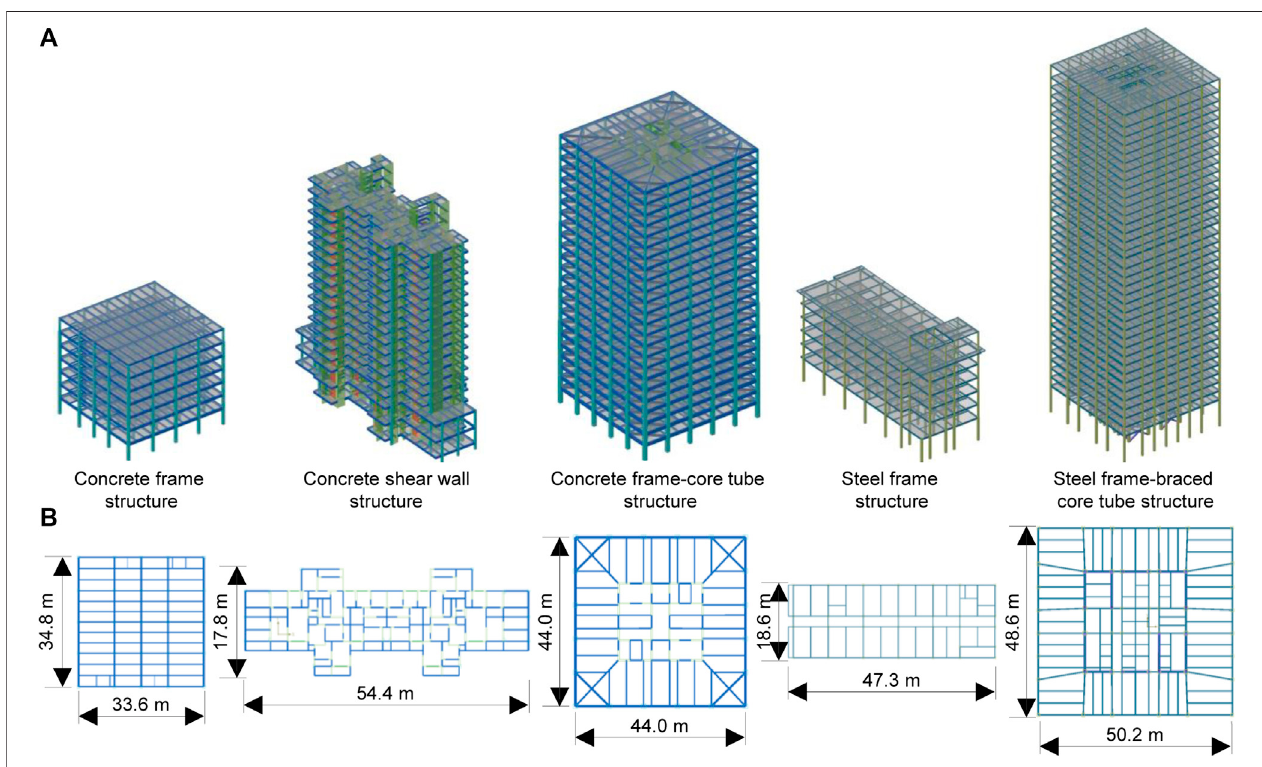
FIGURE 2 | Five typical structures: (A) 3D view and (B) plan view.